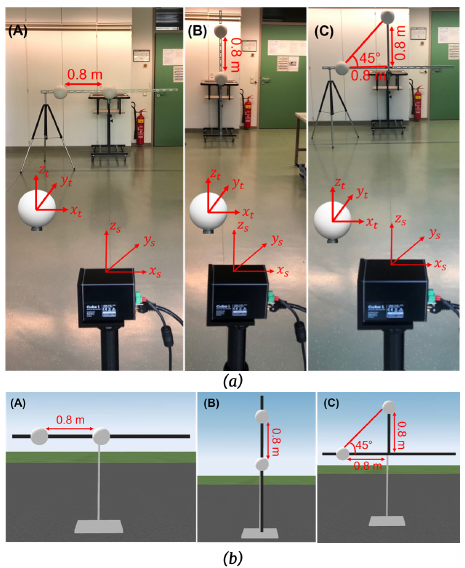
Figure 21. ( a ) Real test setup of asymmetric tests for test positions ( A – C ). ( b ) Static simulation scenes of asymmetric tests for test positions ( A – C ). The simulated and real sphere targets are placed in front of the sensor at approximately 5m. The simulated and real bar length is 2m long, while the distance between the sphere targets is 0.8m. The coordinates of the simulated and actual objects and sensors are the same.